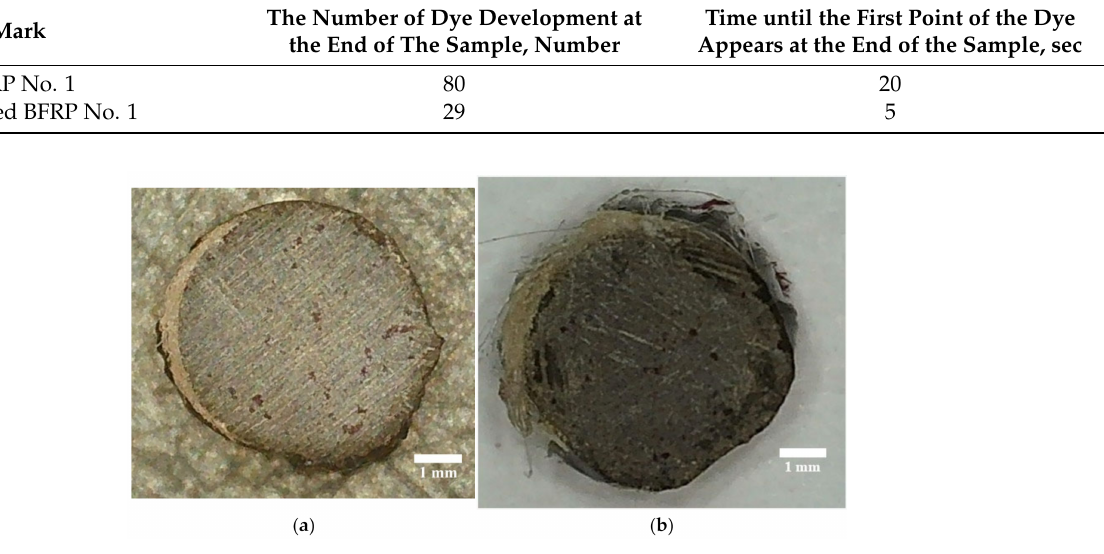
Figure 8. Images of BFRP rebar after testing for monolithicity with a diameter of 6 mm, with the original exposed for 51 months ( a ) and the bio-infected sample after exposure ( b ) for 24